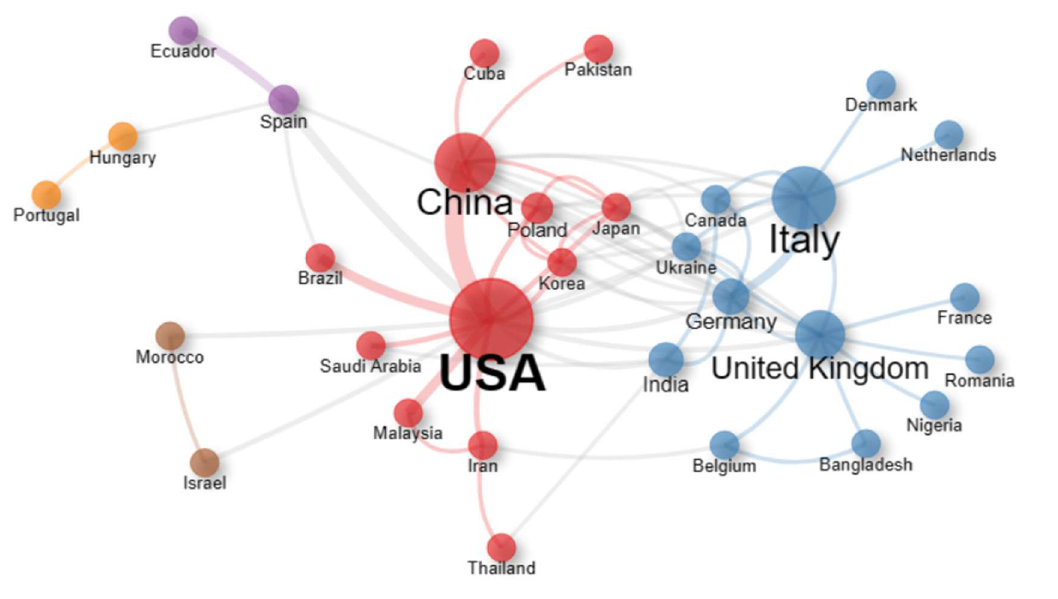
Figure 3. Collaboration network (1988–2022). Source: created by the